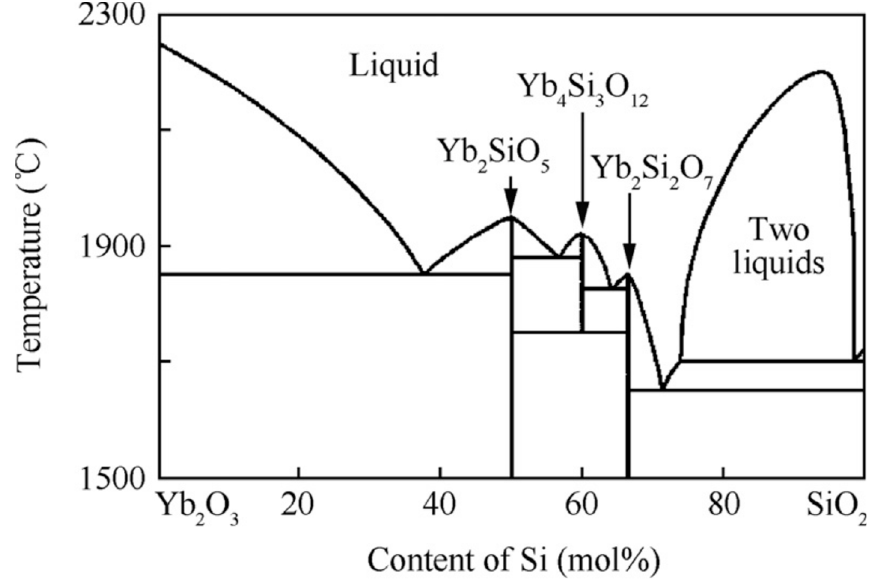
Figure 12. SiO 2 -Yb 2 O 3 pseudo-binary phase portrait.